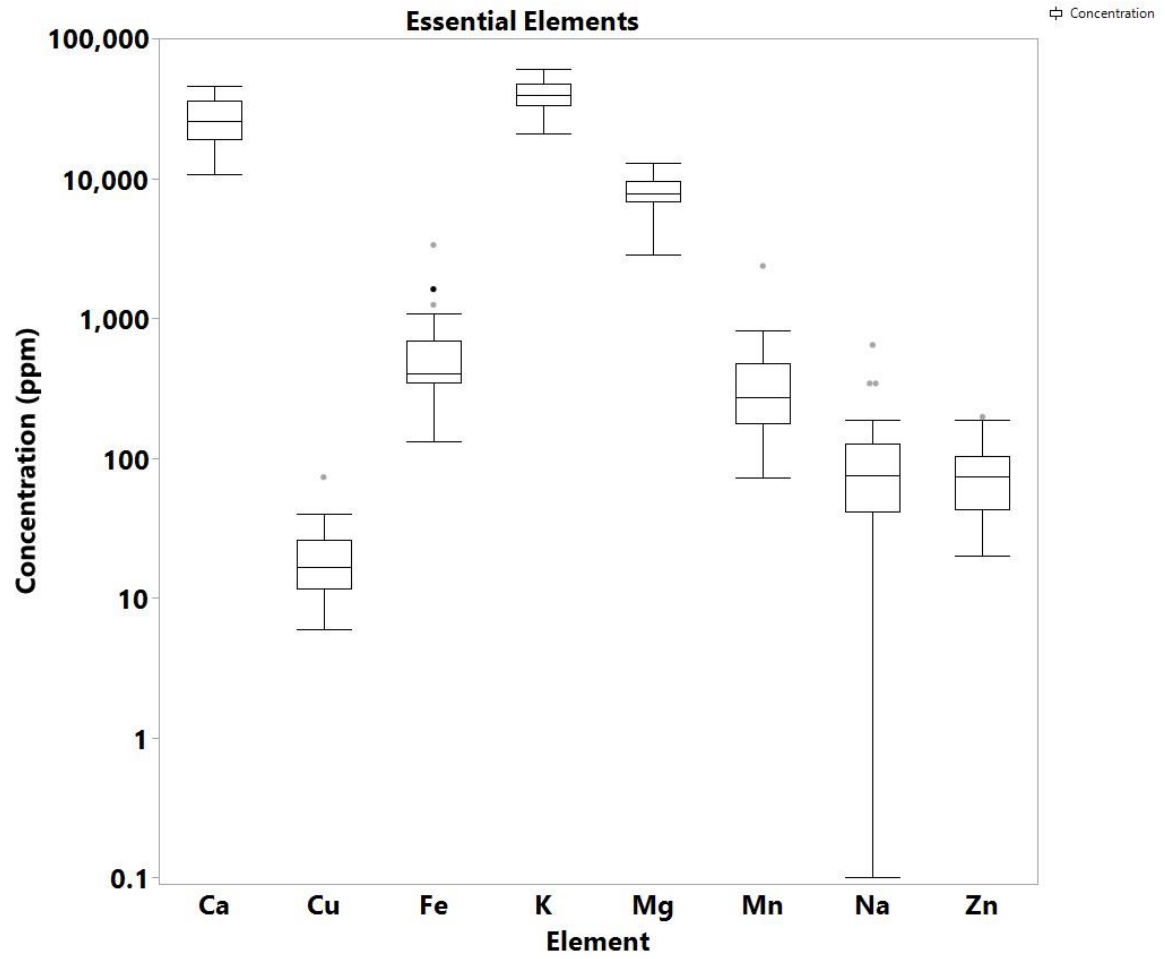
Figure 1. Box plot of essential elements concentration in cannabis samples.